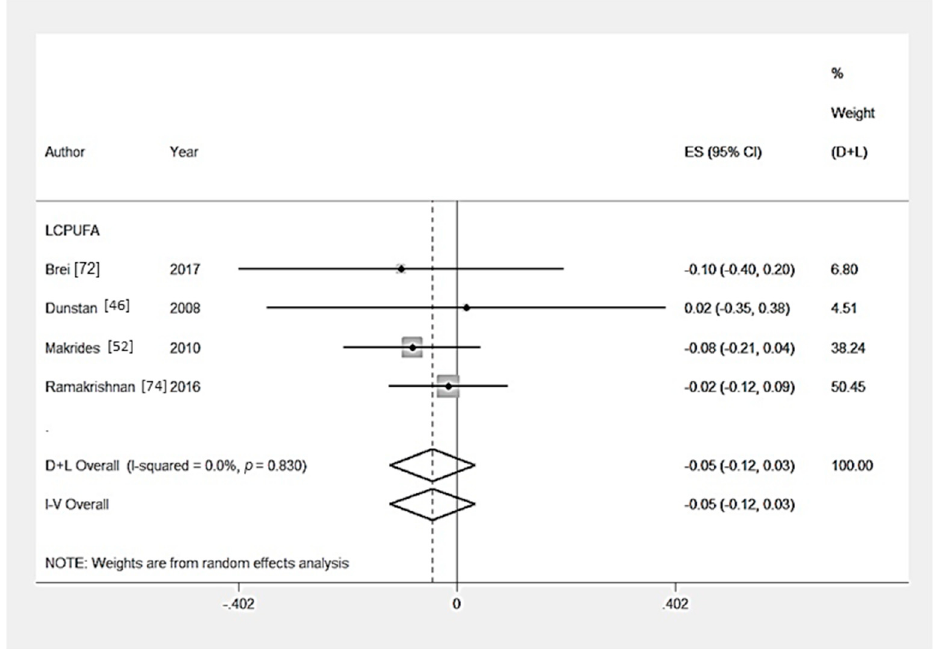
Figure 2. Forest plot for child behaviour outcomes. The overall effect size was estimated by standardised mean difference (SMD). LCPUFA, long chain polyunsaturated fatty acids. D+L, random-effects estimate (Der Simonian and Laird method) and I-V, fixed-effects estimate (inverse variance method).